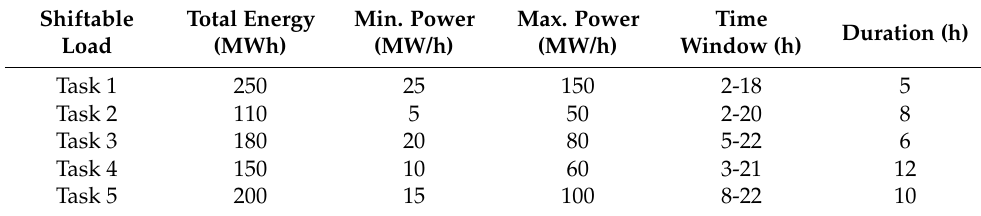
Table A5. Load-shifting program